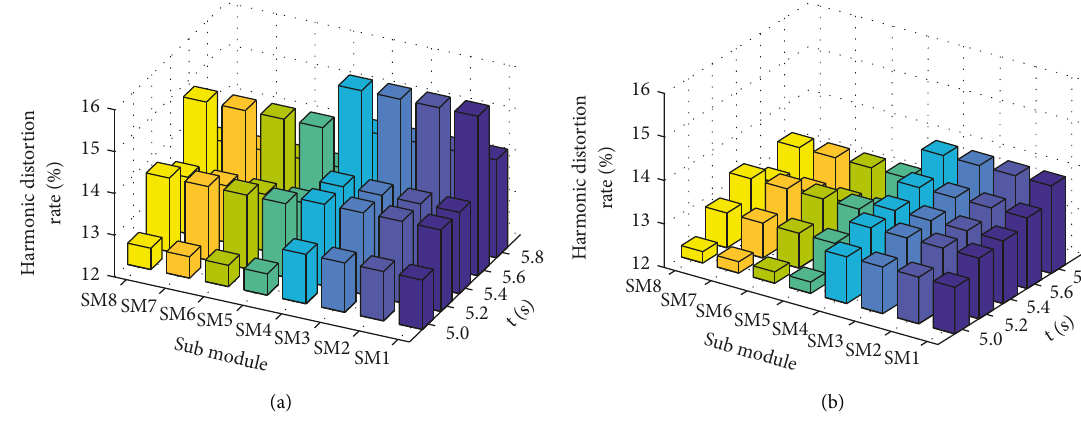
Figure 20: Analysis of harmonic distortion rate of capacitor voltage of c -phase submodule. (a) Harmonic distortion rate of each submodule using one-third average method. (b) Harmonic distortion rate of each submodule of sliding window integral